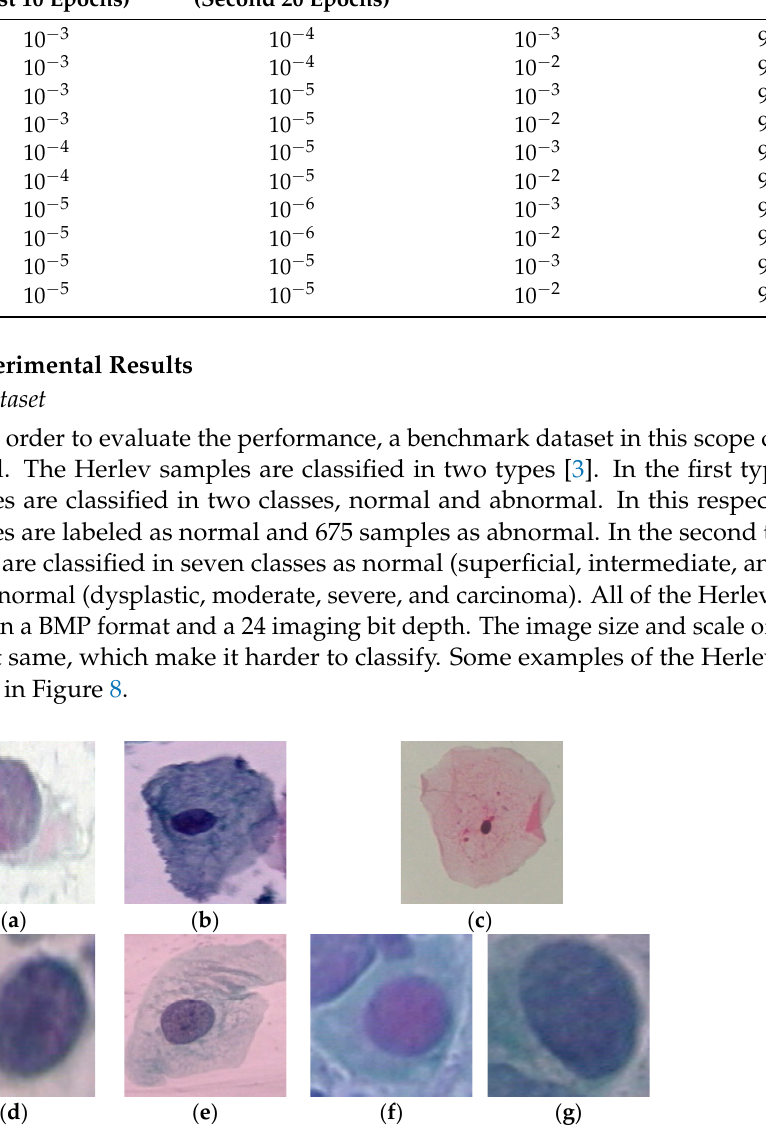
Figure 8. Some samples of the Herlev dataset [3]. ( a ) Normal columnar cell; ( b ) Normal intermediate cell; ( c ) Normal superficial cell; ( d ) Abnormal carcinoma in situ cell; ( e ) Abnormal light dysplastic cell; ( f ) Abnormal cell moderate dysplastic cell; ( g ) Abnormal severe dysplastic